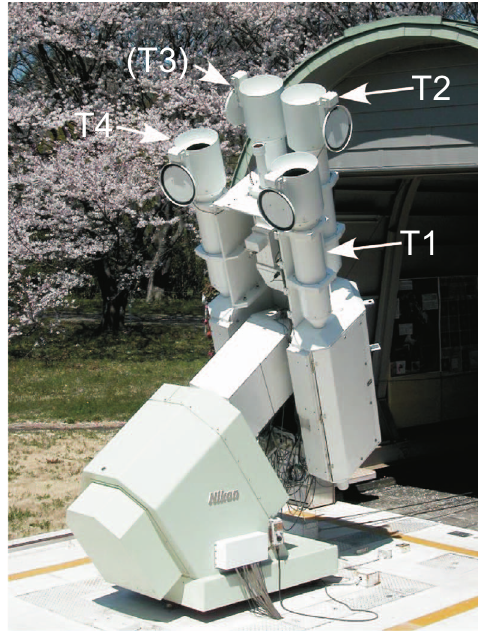
Fig. 1. Picture of the Solar Flare Telescope of NAOJ. It has four refractor tubes designated as T1 –